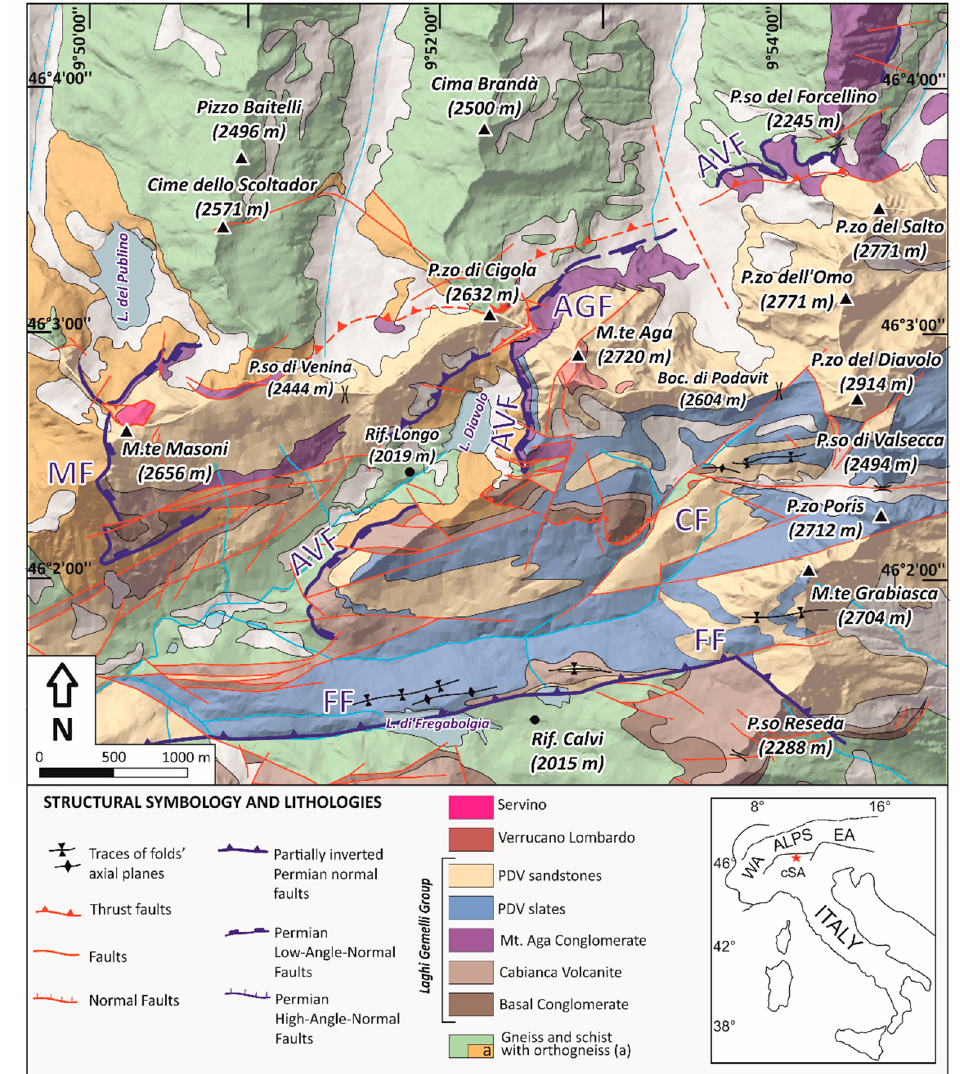
Figure 2. Simplified geological maps of the upper Brembana and Vedello valleys displaying the traces of the Aga-Vedello (AVF) and Masoni (MF) LANFs. AGF: Aga Growth Fault; CF: Camisana Fault; FF: Fregabolgia Fault. The Forcellino Pass is in the NE corner of the map. Modified from [9].